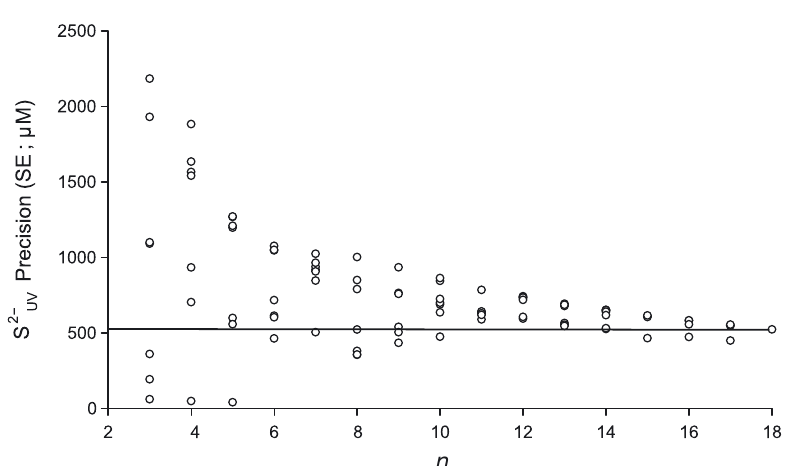
n Fig. 6. Relationship between the precision (SE) of total free sulfide measure- ments (S 2− UV ), based on UV spectrophotometry, and the number of replicate sediment samples (n) collected at the edge of salmon net-pens at Farm A. The data points show SE values calculated from randomized draws of n size from a pool of 18 replicate S 2− UV measurements. The horizontal line is the SE for all 18 replicate lected in traps at the 50, 200, and 500 m stations also declined with distance from 11.7−8.8%. Simultaneous measurements of OM flux at the farm edge, reported in Law & Hill (2019), are included in Fig. 9 and indi- cate that OM flux was lowest at the farm edge. OM